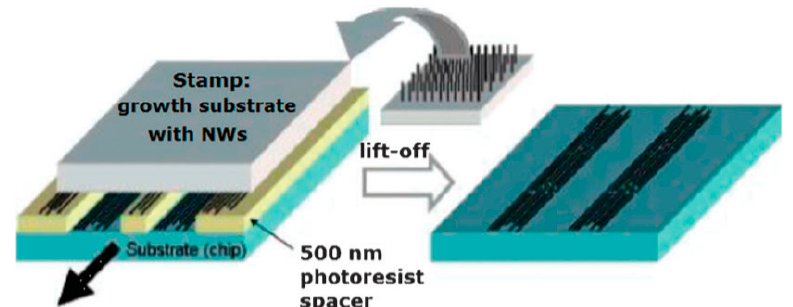
Figure 18. Contact printing of NWs from a growth substrate on a prepatterned substrate. In general, NWs are grown perpendicularly to substrate with a random orientation, but they can be well-aligned by shear forces during the printing process. Reproduced with permission from Javey et al. [271]. Copyright 2007: Royal Society of Chemistry.